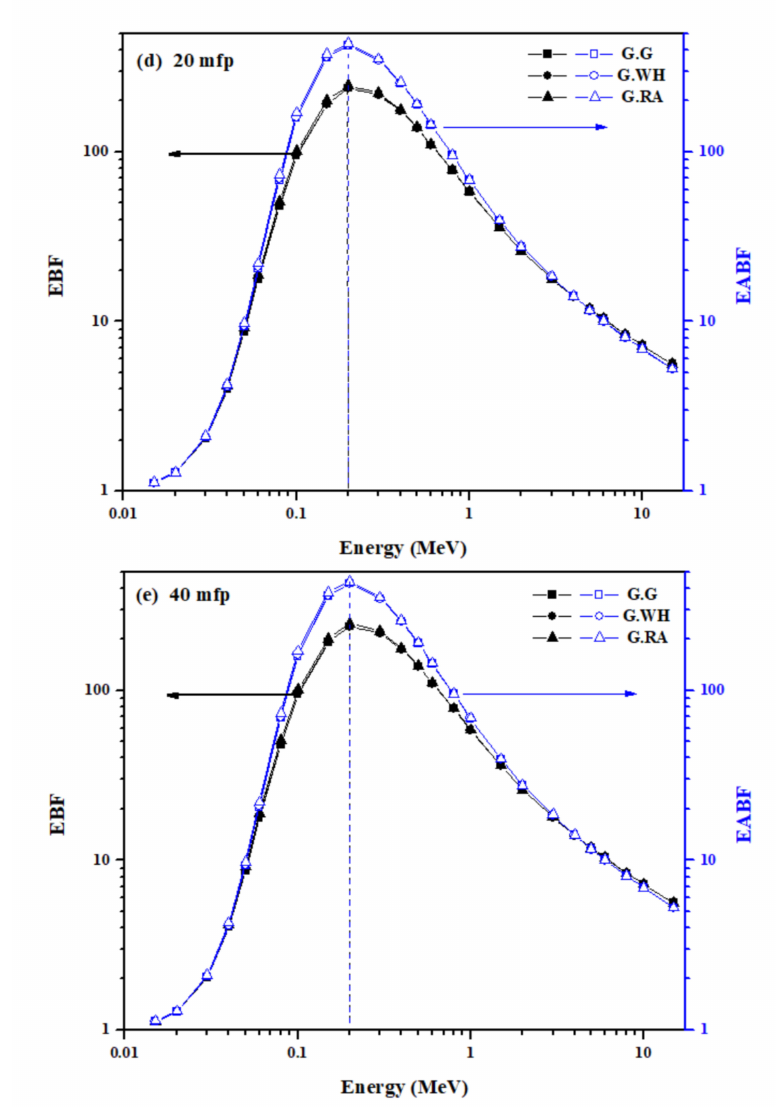
Figure 7. Variation of the calculated values of exposure buildup factor (EBF) and energy absorption buildup factor (EABF) with photon energy for the granite samples in the energy range 0.015 to 15 MeV at the depth penetration ( a ): 1 mfp; ( b ): 5 mfp; ( c ): 10 mfp; ( d ): 20 mfp, and ( e ): 40